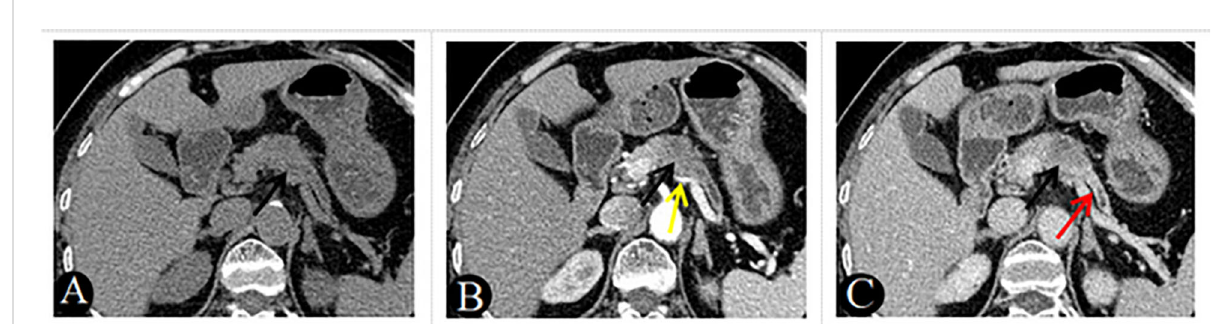
FIGURE 3 A 69-year-old woman with PDAC, absence of clinical symptoms, CA199 positive. Axial unenhanced (A) , pancreatic parenchymal (B) , and portal (C) phases CT images, demonstrated a low-attenuation nodules approximately 25mm in diameter in the neck of the pancreas (black arrow). The lesion showed gradual enhancement type and ill-de fi ned margins, associated with main pancreatic duct dilatation ( C , red arrow) and atrophy of the body and tail of the pancreas (A – C) . Note also the involvement of the splenic artery, which is narrowed ( B , yellow